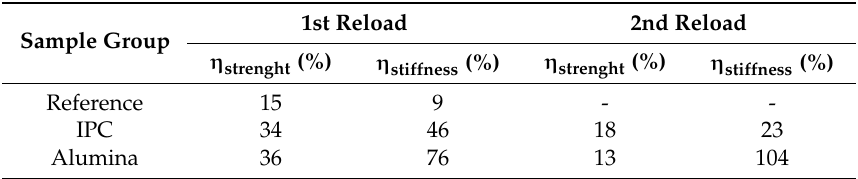
Table 1. The mean mechanical recovery of the beams carrying short capsules under three-point-bending.